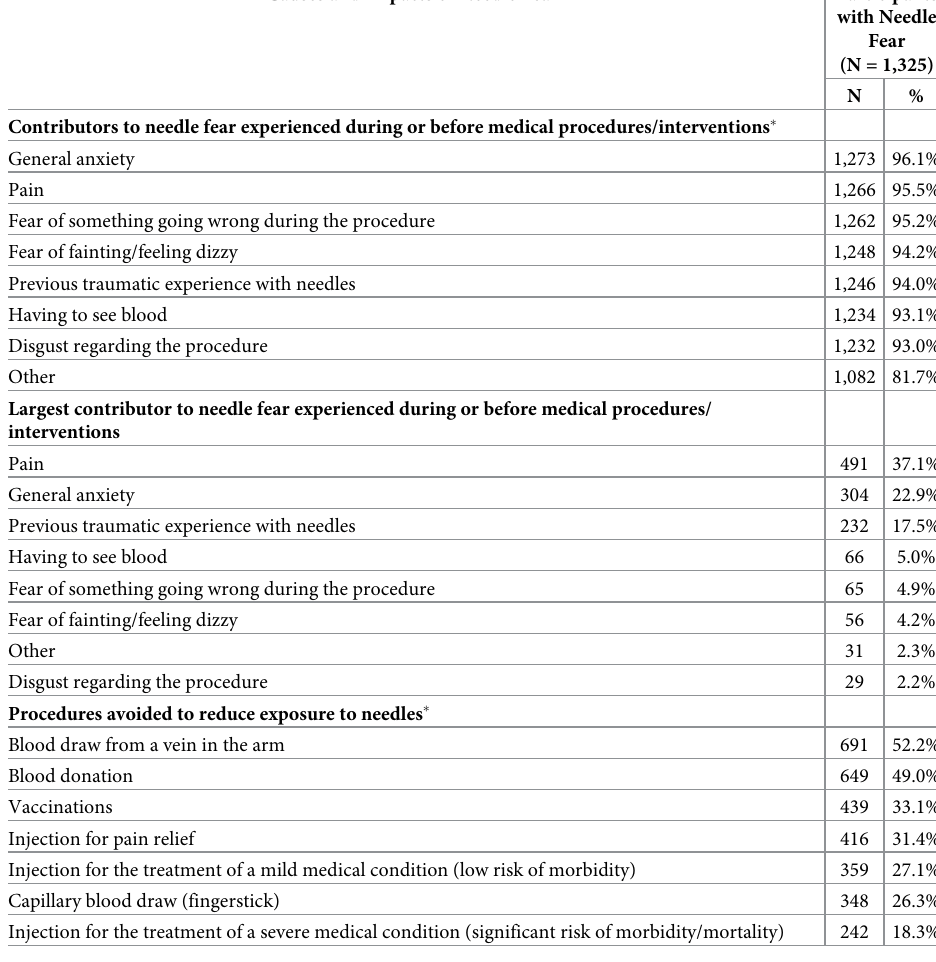
Causes and Impacts of Needle Fear Participants